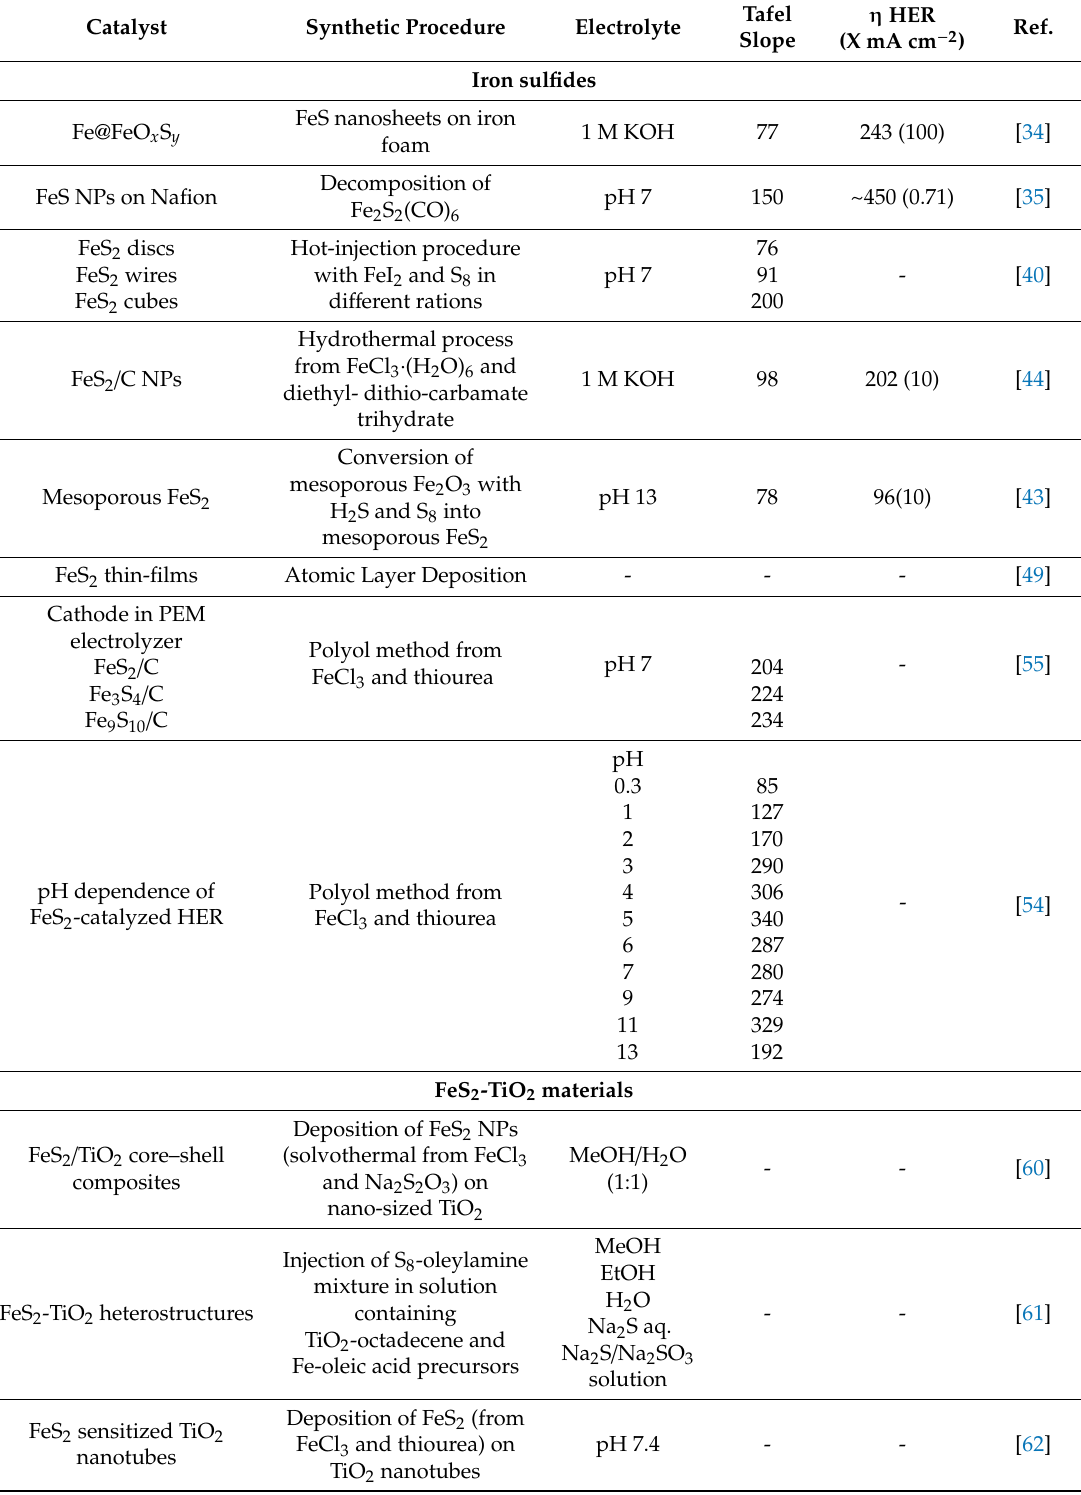
Table A1. Synthetic procedures and HER performance data (Tafel slope (mV dec − 1 ), over potential η (mV)) for discussed iron sulfide